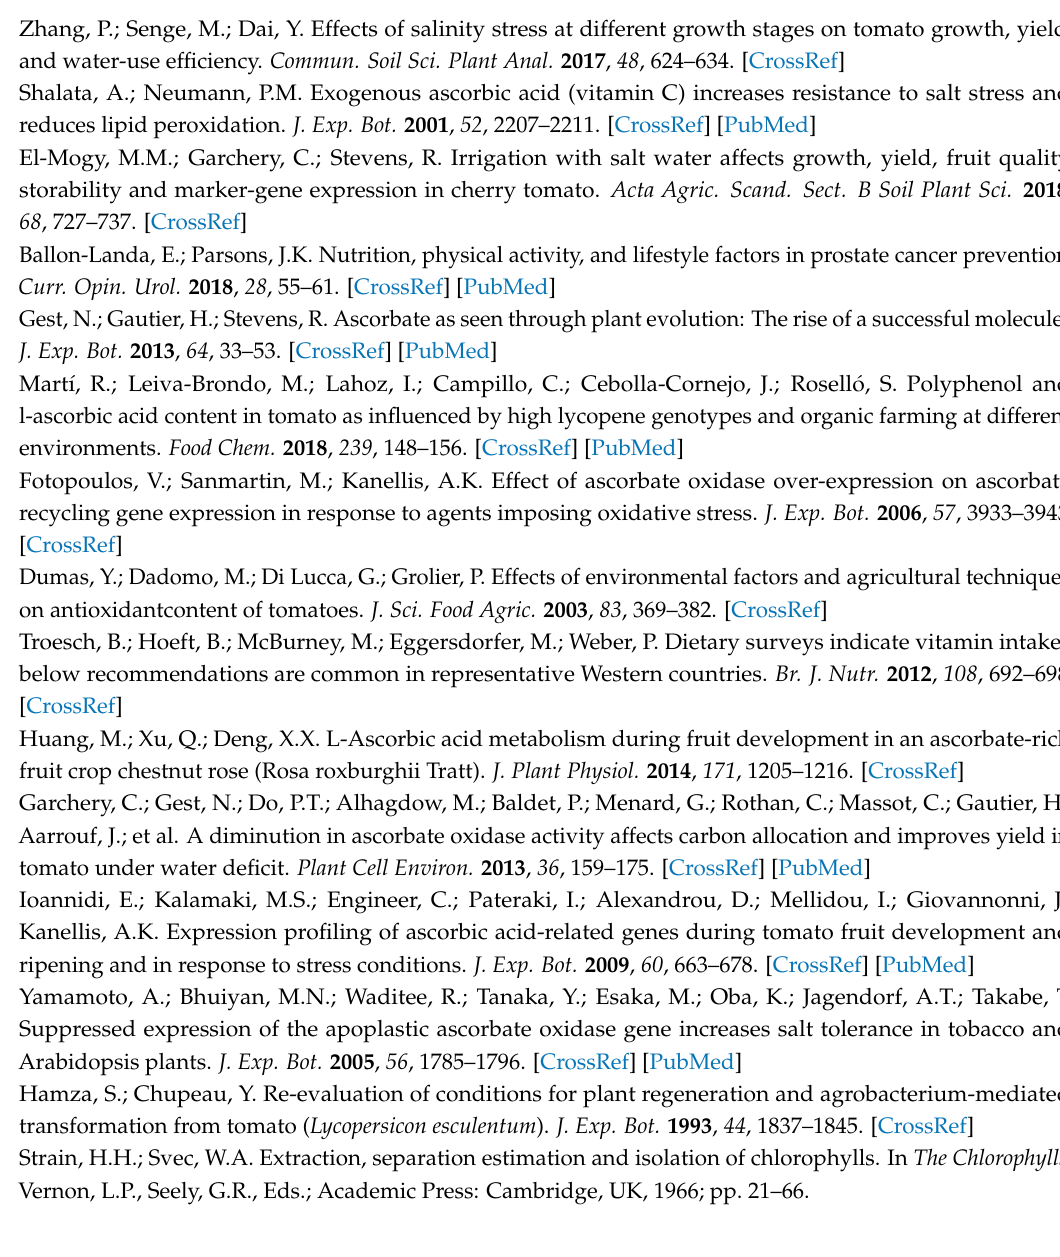
Figure S1. The effect of three salinity levels 0 mM (black bars), 75 mM (speckled bars), and 150 mM NaCl (striped bars) on cherry tomato lines (A) SPAD reading in 2015, (B) SPAD reading in 2016, (C) mean fruit weight in 2015, (D) mean fruit weight in 2016, (E) fruit diameter in 2015, and (F) fruit diameter in 2016. Table S1. Chlorophyll a content ( µ g g − 1 FW) of lines with low or elevated AO activity and non-transgenic lines of red-ripe cherry tomato fruits under two salinity levels (75 and 150 mM NaCl) in 2015 and 2016. Table S2: Chlorophyll b content ( µ g g − 1 FW) of lines with low or elevated AO activity and non-transgenic lines of red-ripe cherry tomato fruits under two salinity levels (75 and 150 mM NaCl) in 2015 and